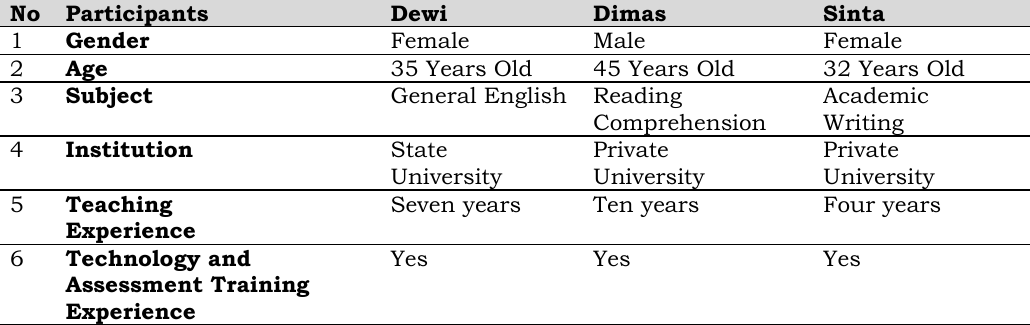
Table 1. Personal Information of the